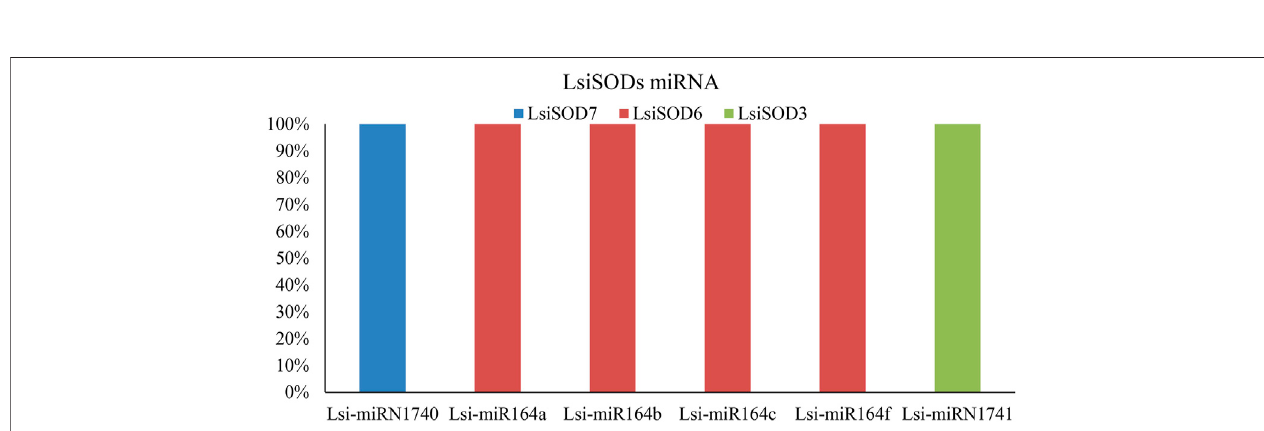
FIGURE9| SODstargetedbymiRNAsof Lagenariasiceraria (bottlegourd).TheRNAsequenceofeachcomplementarysitefrom5 ′ to3 ′ andthepredictedmiRNA sequence from 3 ′ to 5 ′ are shown in the expanded regions.